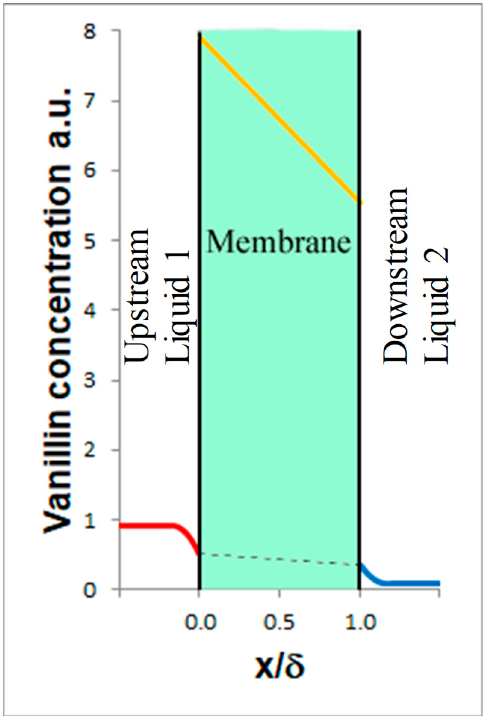
Figure 5. Scheme of the dialysis process (dialysis membrane with Liquid 1, upstream, and Liquid 2, downstream) with exemplificative concentration profile of vanillin (red curve in Liquid 1, yellow curve in the membrane, and blue curve in Liquid 2).